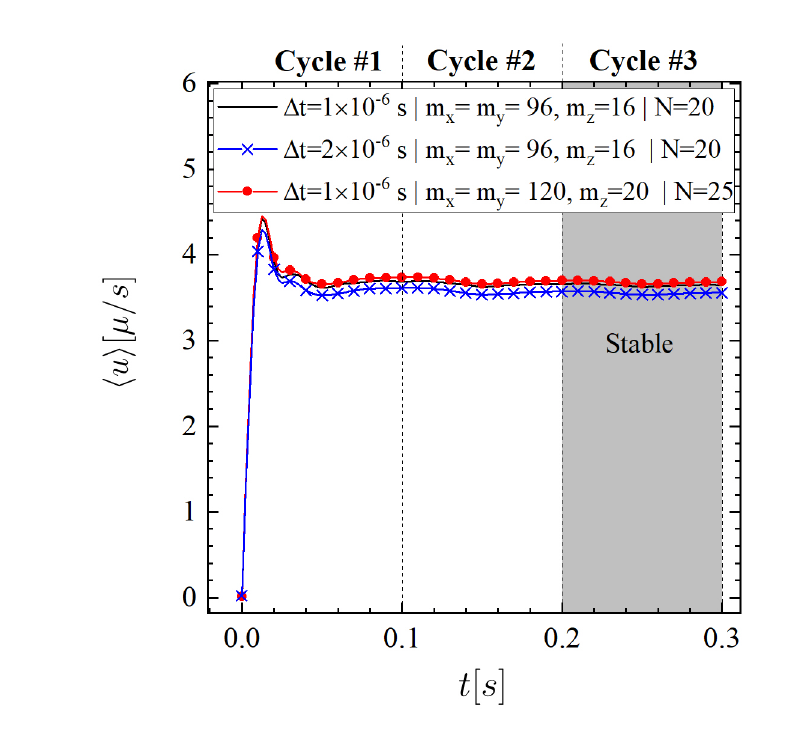
Figure 4. Numerical convergence study by varying the time step size ∆ t , number of fluid grids (i.e., m x , m y , m z ), and number of control points N